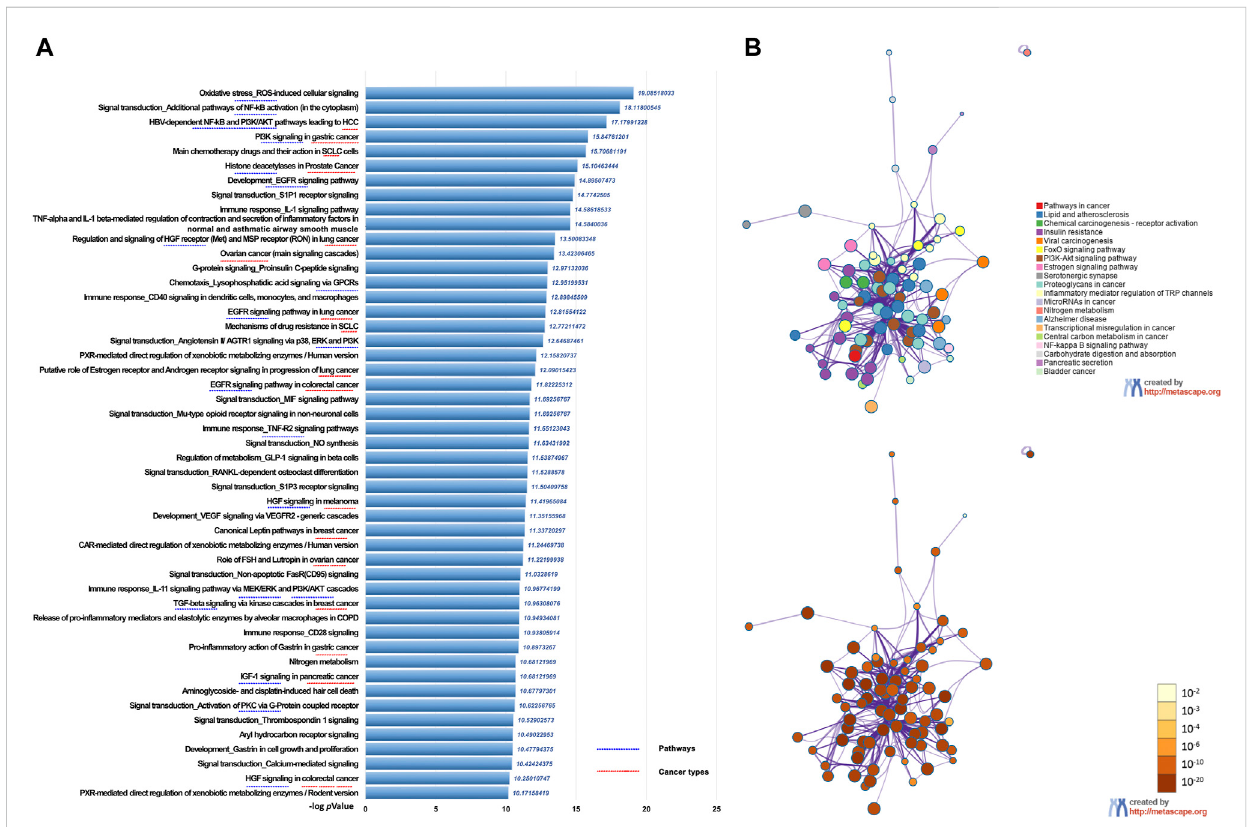
FIGURE 2 Functional enrichment analysis of CR target genes. (A) Functionally enriched pathways of the CR targets genes using Metacore. (B) Network of pathways enrichment analysis by